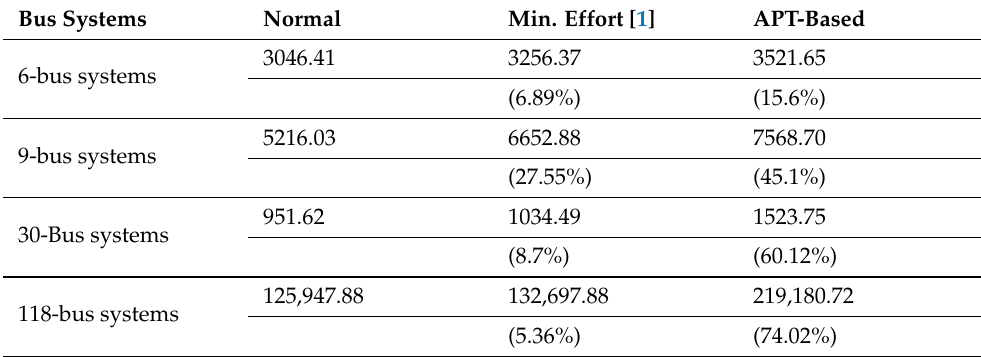
Table 6. Comparison between our work and the work in Reference [1]. Bus